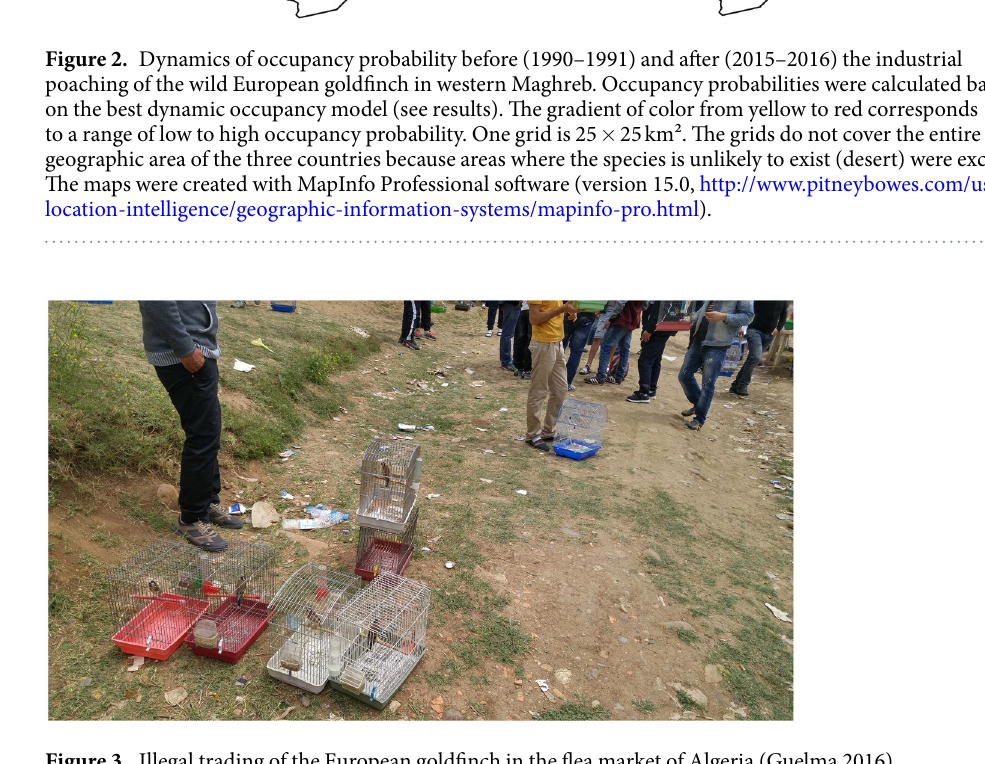
5 Scientific RepoRts | 7: 1092 | DOI:10.1038/s41598-017-01103-w